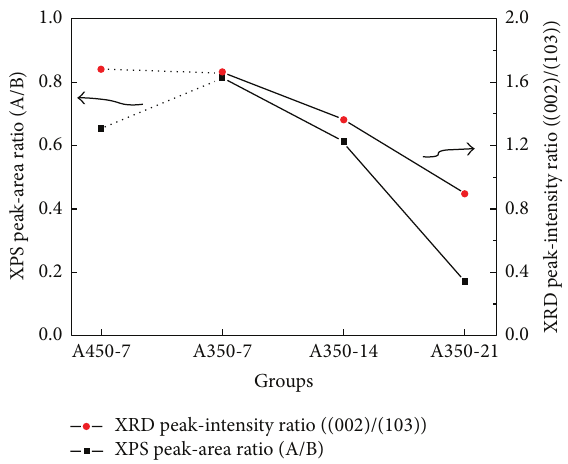
Figure 5: O1s XPS A/B peak-area ratios and the (002)/(103) XRD peak-intensity